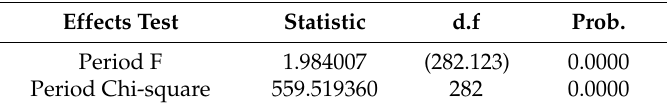
Table 7. Test for redundant fixed effects. Source: Authors’ work.